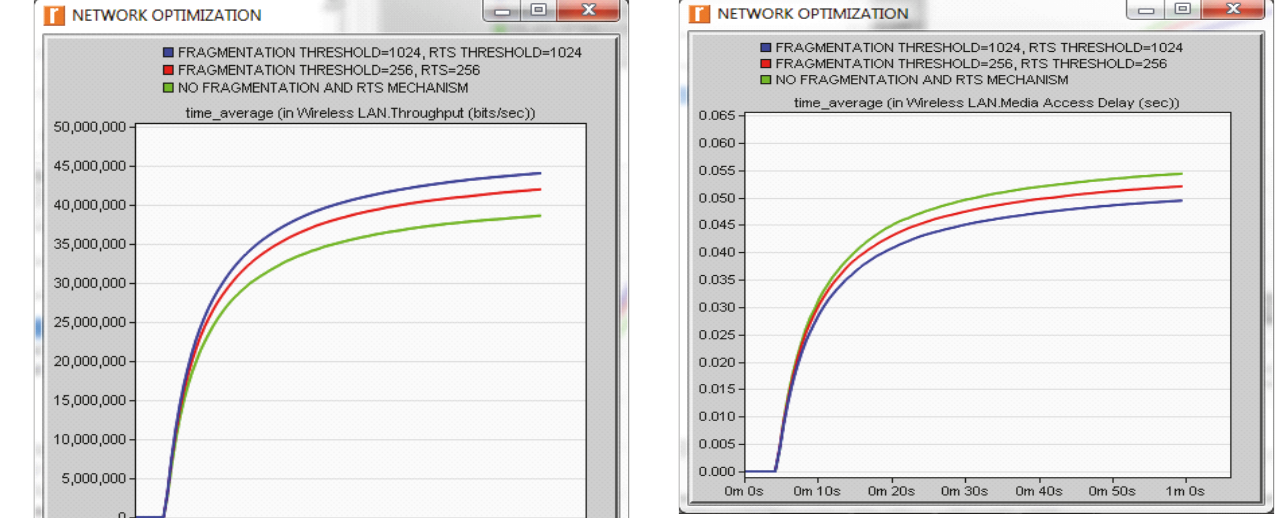
Figure 24: WLAN media access delay optimization with different values of RTS and fragmentation thresholds.